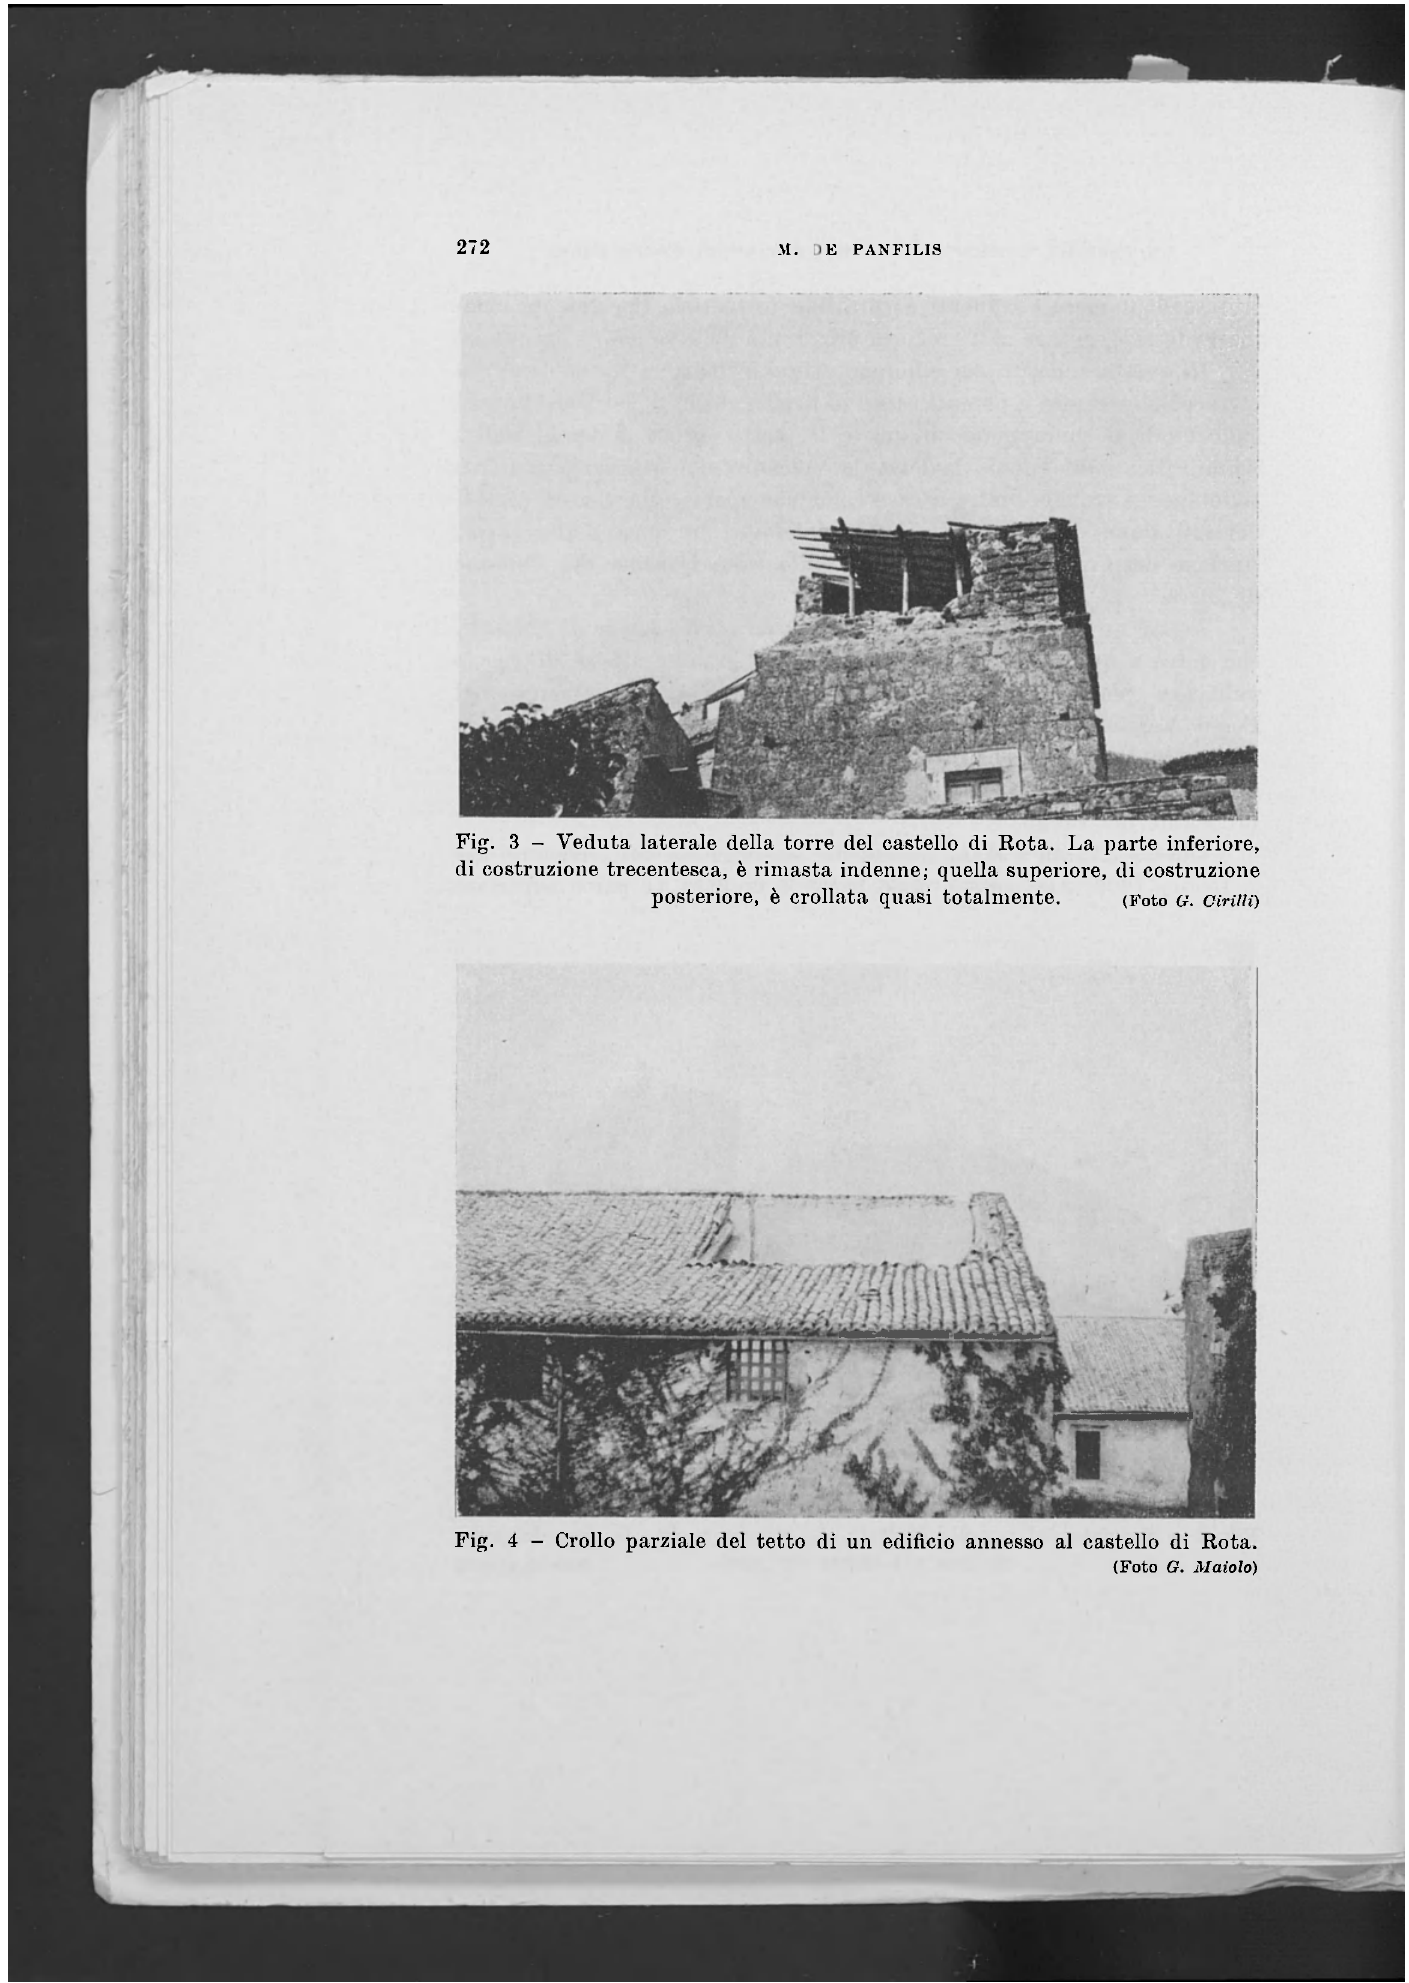
Fig. 4 - Crollo parziale del tetto di un edificio annesso al castello di